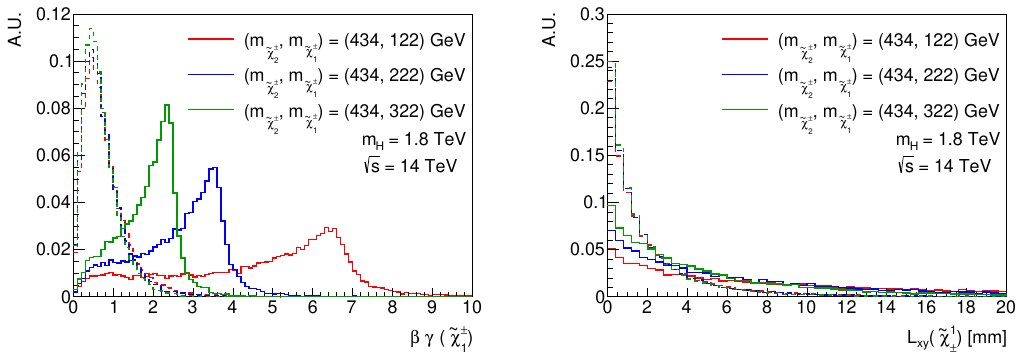
Figure 12. The boost received by lightest chargino (left) and the resulting transverse displacement distribution (right) when chargino is produced in Drell-Yan processes (dashed lines) vs. chargino produced via decays of heavy Higgs (solid lines). The mass of heavy Higgs and heavier chargino is fixed at 1.8TeV and 434 GeV respectively, the mass of lighter chargino is varied, mass difference between χ ± , χ 0 is fixed at 0.5 e e 1 1